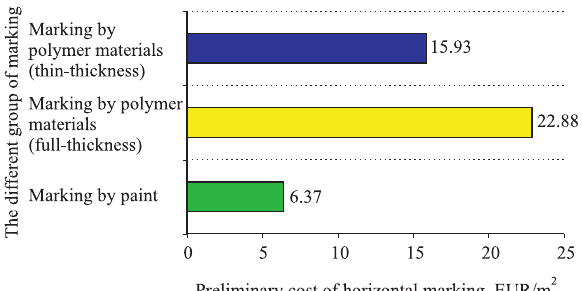
Fig. 8. Preliminary cost of horizontal marking (Accumulation and renewal of traffi c data of the roads of national signifi cance,